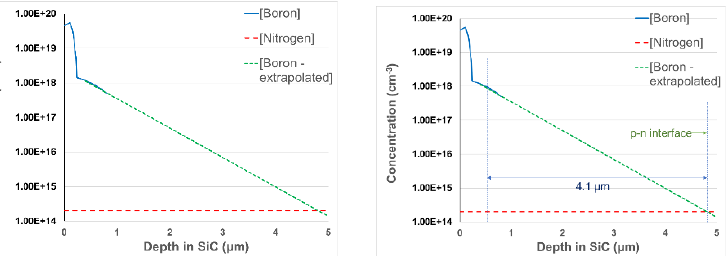
Fig. 4. (a) Measured [11] and extrapolated diffused-boron concentrations in SiC compared to the nitrogen-dopant concentration. (b) The p-n interface corresponds to the location where the boron and nitrogen concentrations are